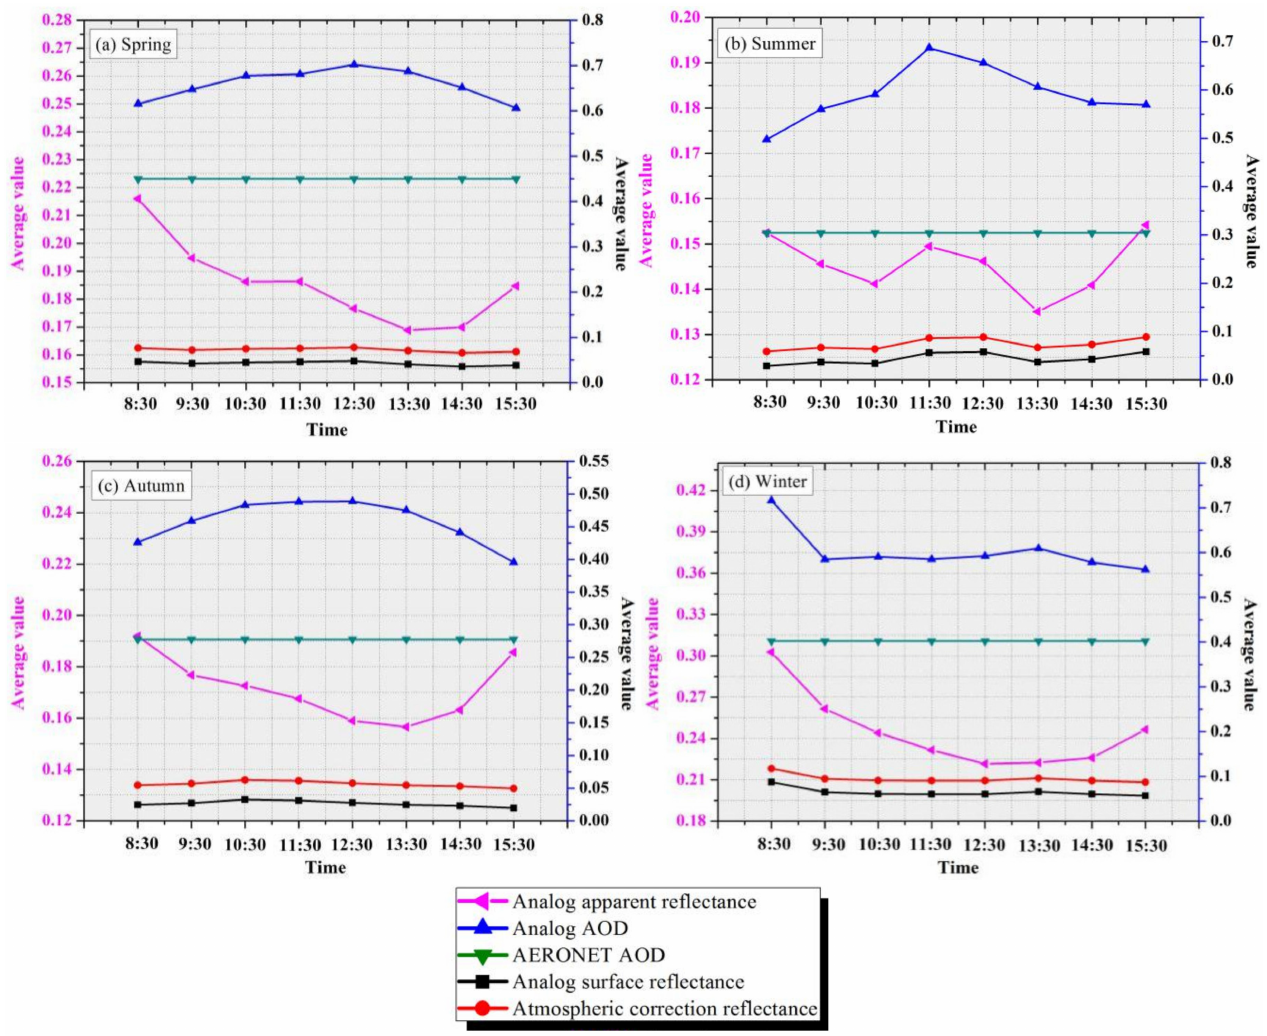
Figure 10. The influence of surface changes in four seasons on the retrieval of GOCI AOD. (The value of apparent reflectance is shown on the left ordinate, and the ordinate of the remaining four curves are the right